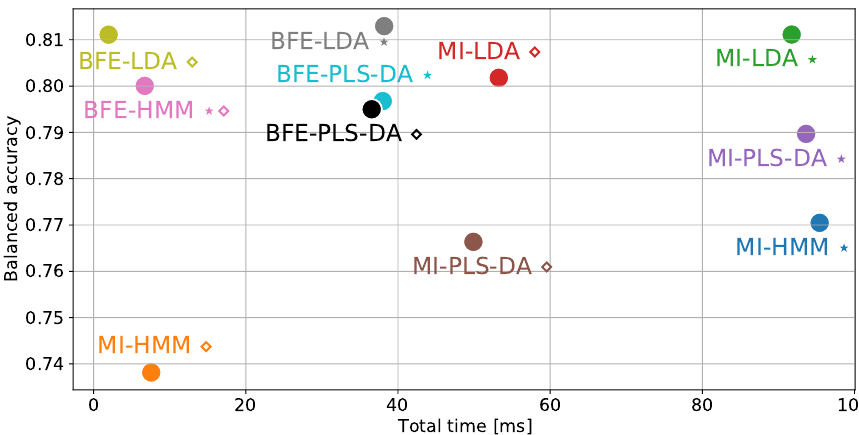
Figure 4. Graphical comparison of dimensionality reduction and classification algorithms, in terms of time complexity and performance.